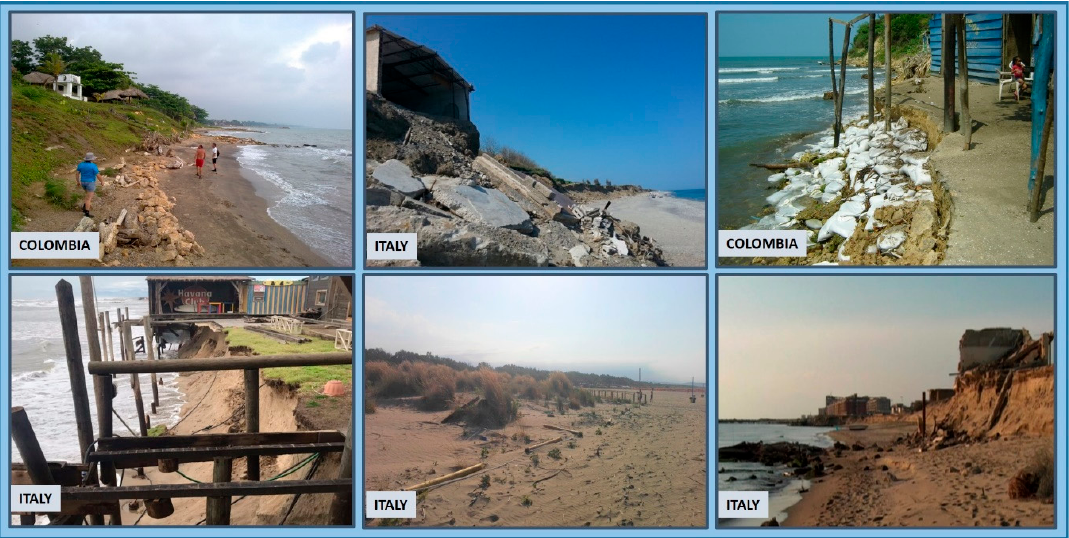
Figure 2. Examples of chronic erosion along low coastal areas in Italy and Colombia. Source: Giorgio Anfuso, Angela Rizzo, Gianluigi Di Paola.